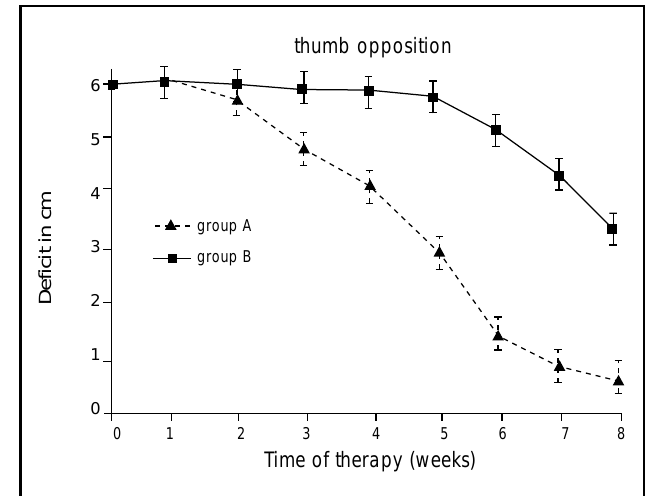
Figure 5: Development of the thumb function in the course of therapy.